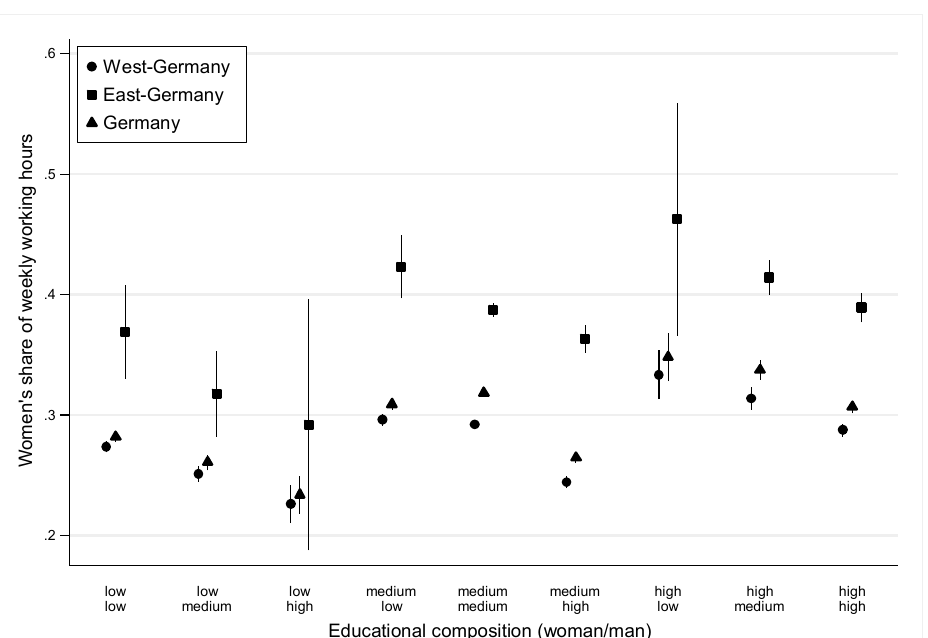
Figure 1 : Adjusted predictions for women’s share of weekly working hours, by relative education and